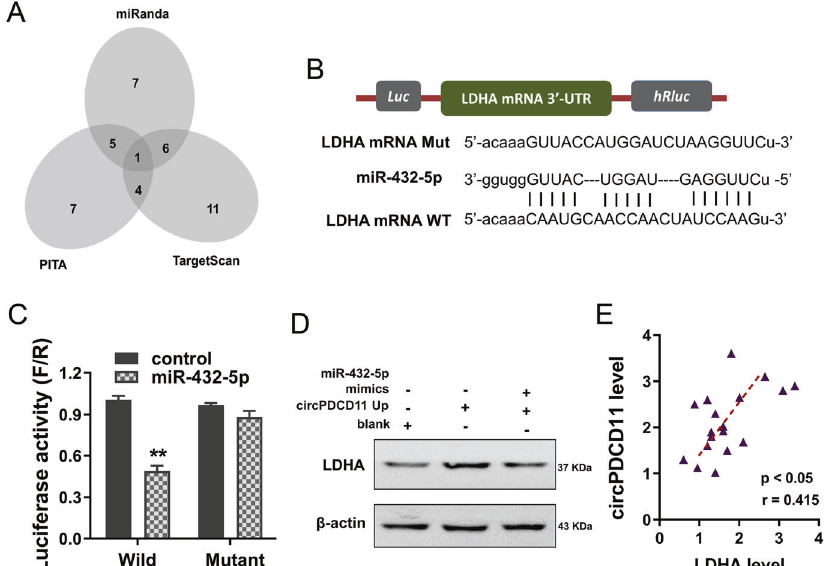
Fig. 5 LDHA was identi fi ed to be targeted by circPDCD11/miR-432-5p. A Online bioinformatics predictive tools identi fi ed the potential targets of circPDCD11/miR-432-5p. B The multiple complementary binding sites within miR-432-5p and LDHA, including wild type and mutant. C The luciferase reporter assay demonstrated the close interaction between wild-type LDHA mRNA 3 ′ -UTR and miR-432-5p. The fl uorescence intensity was assessed. D Western blot analysis assessed the LDHA protein level in BT549 cells transfected with circPDCD11 overexpression and/or cotransfected with miR-432-5p mimics. E Clinical correlation analysis calculated by Pearson ’ s correlation showed the correlation between circPDCD11 and LDHA. The data are presented as the means ± SD. Asterisks indicate signi fi cant differences (** p <